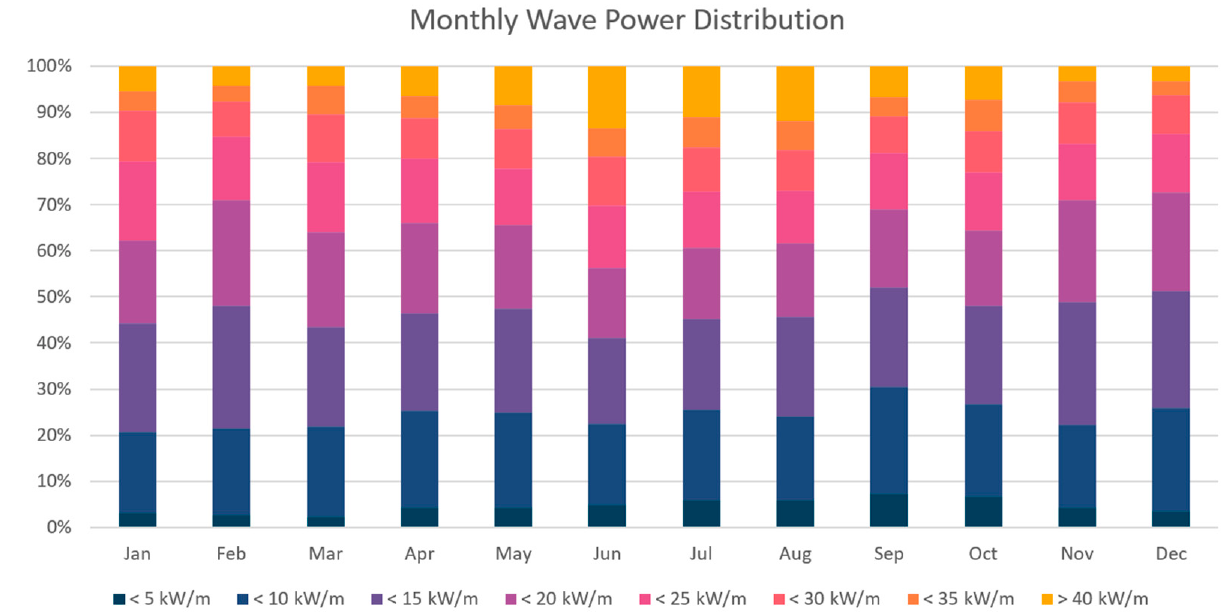
Figure 2. Monthly wave power (kW/m) distribution at the OSL site in Las Cruces.